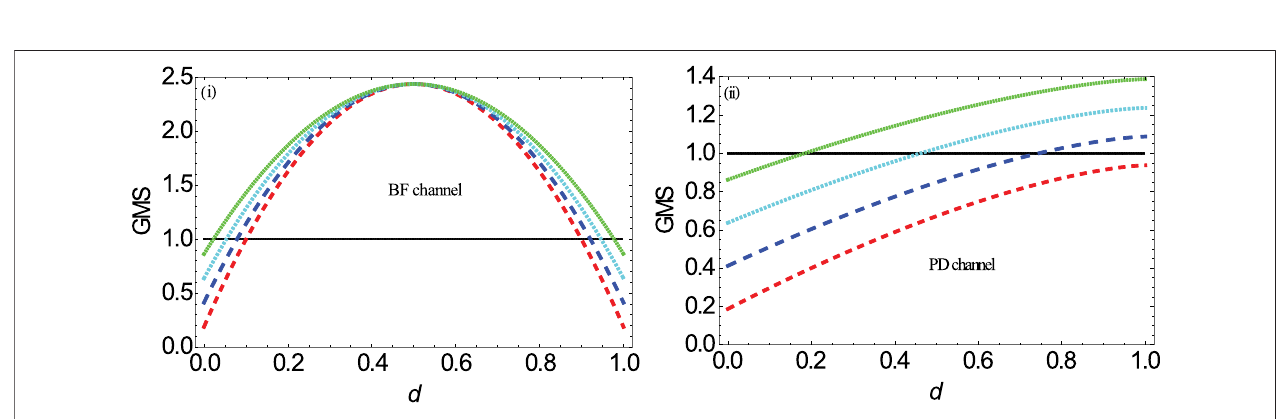
FIGURE 3 | (Color online) GMS inequality as a function of the state parameter Q in terms of different channel-noise factors d for α (cid:2) channels. (1) BF channel. (2) PD channel.